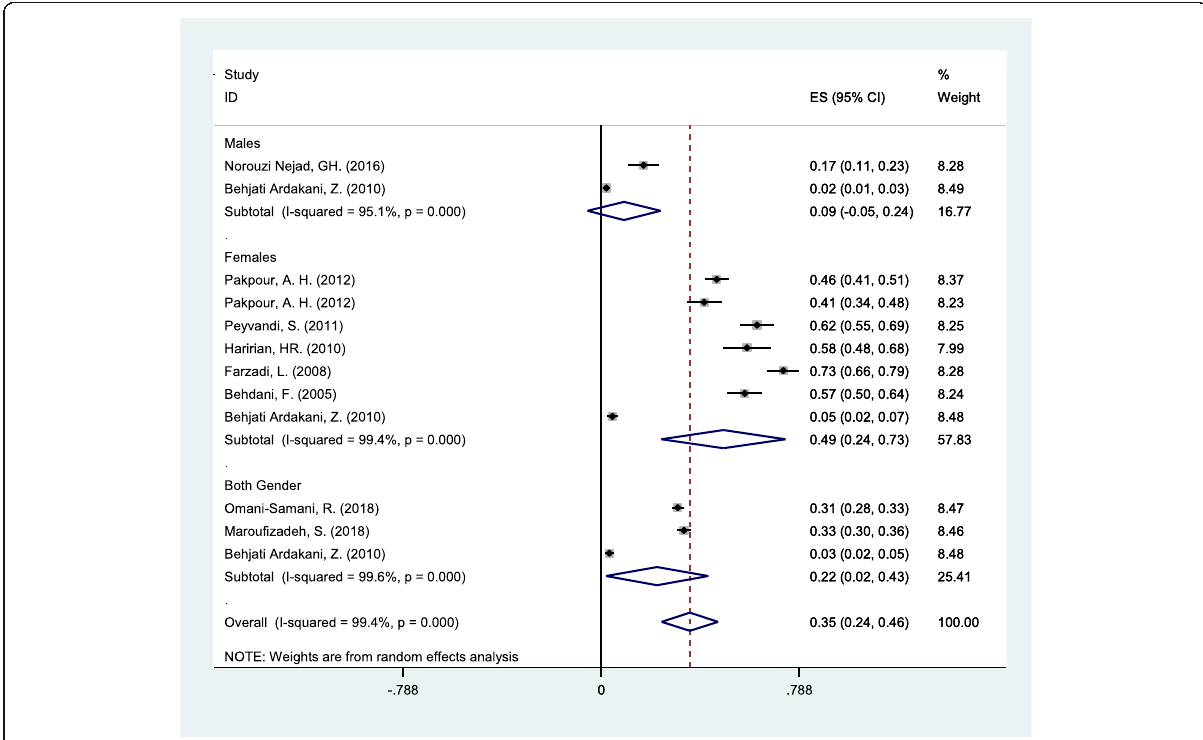
Fig. 2 Prevalence of depression among Iranian infertile